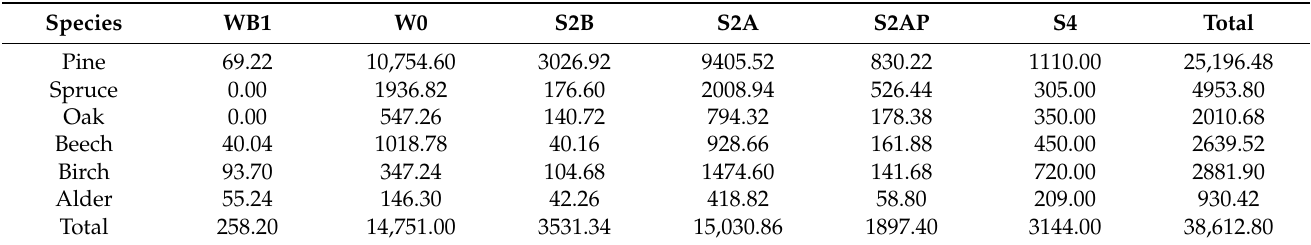
Table 1. The timber volume harvested annually in Polish State Forests as an average from the period